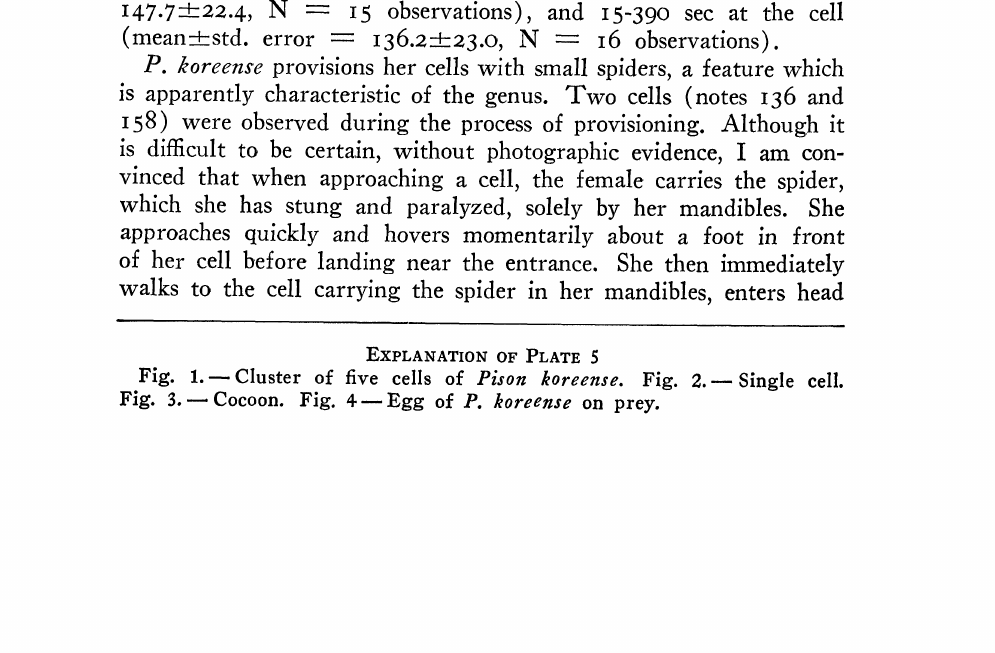
Fig. 3.--Cocoon. Fig. 4mEgg of P. koreense on